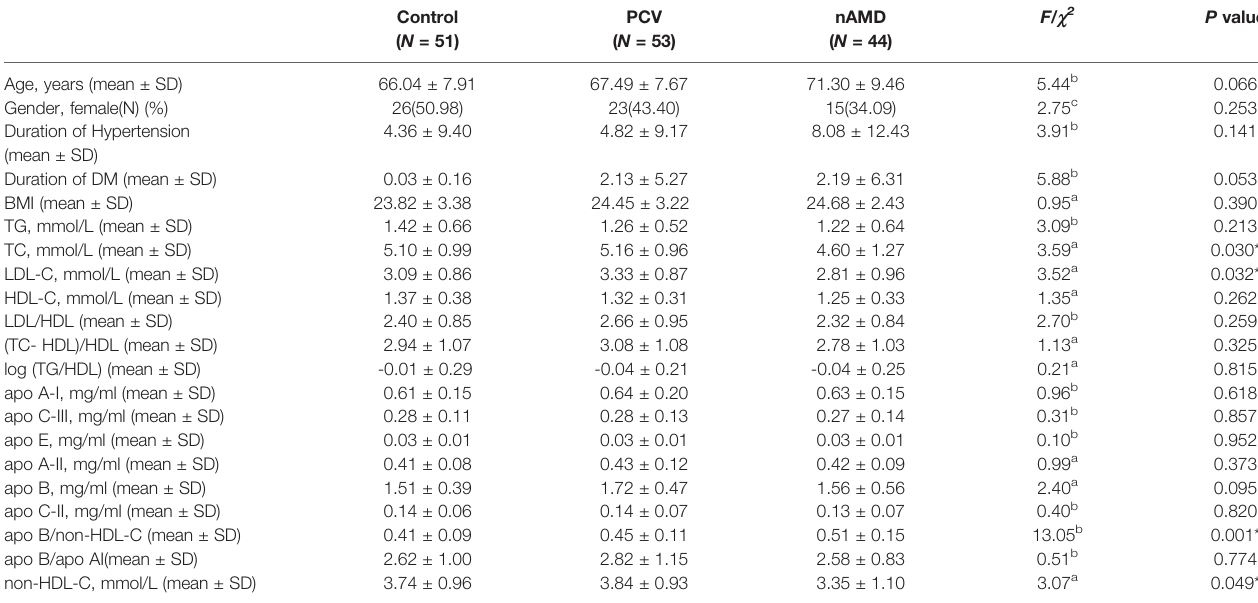
TABLE 1 | Baseline demographic characteristics and biochemical parameters in subjects with PCV, nAMD and